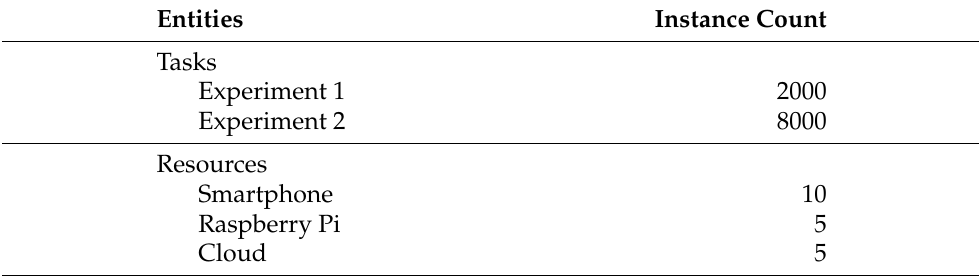
Table 6. Experiment